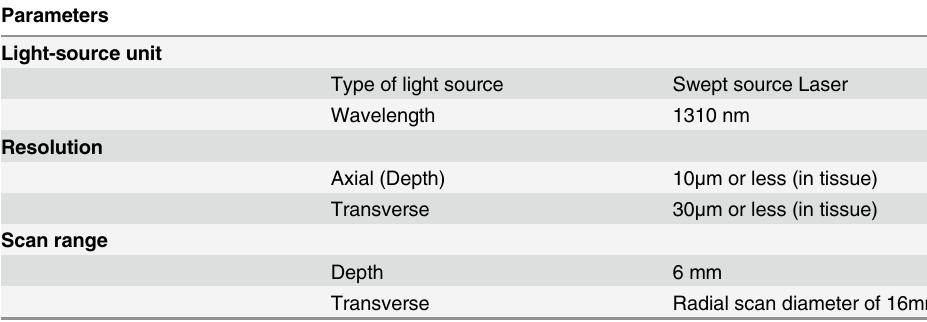
Table 1. Parameters of swept source optical coherence tomography (SSOCT) in the radial three- dimensional (3-D) scan